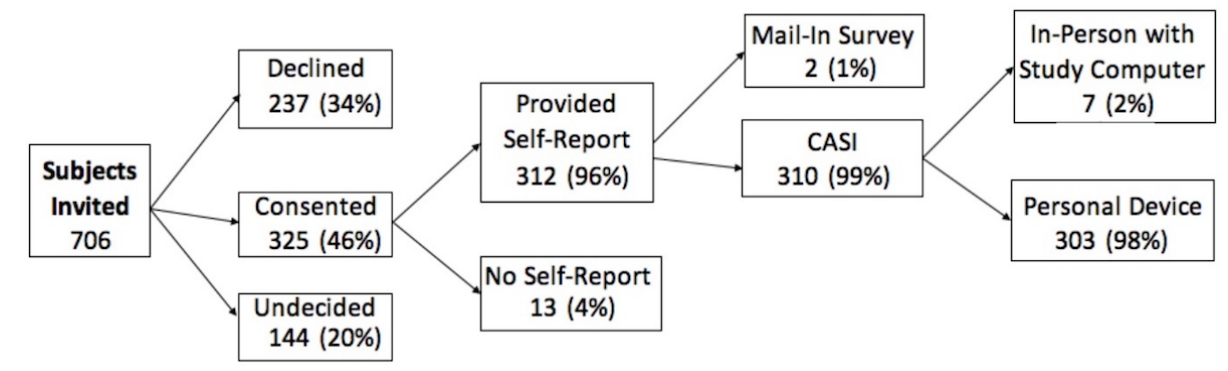
Figure 2. Enrollment flowsheet for CASI data collection instrument analyses. CASI: computer-assisted